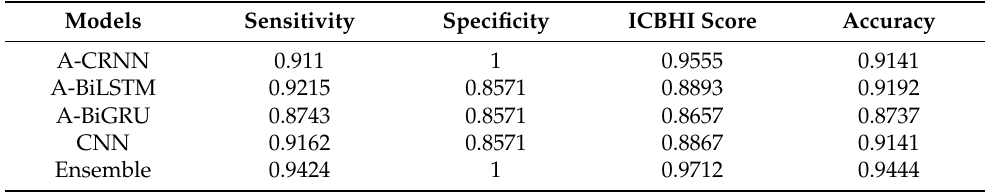
Table 22. Results of the base and ensemble models using a subject-independent train–test split for D5, i.e., the combination of ICBHI and Coswara breathing